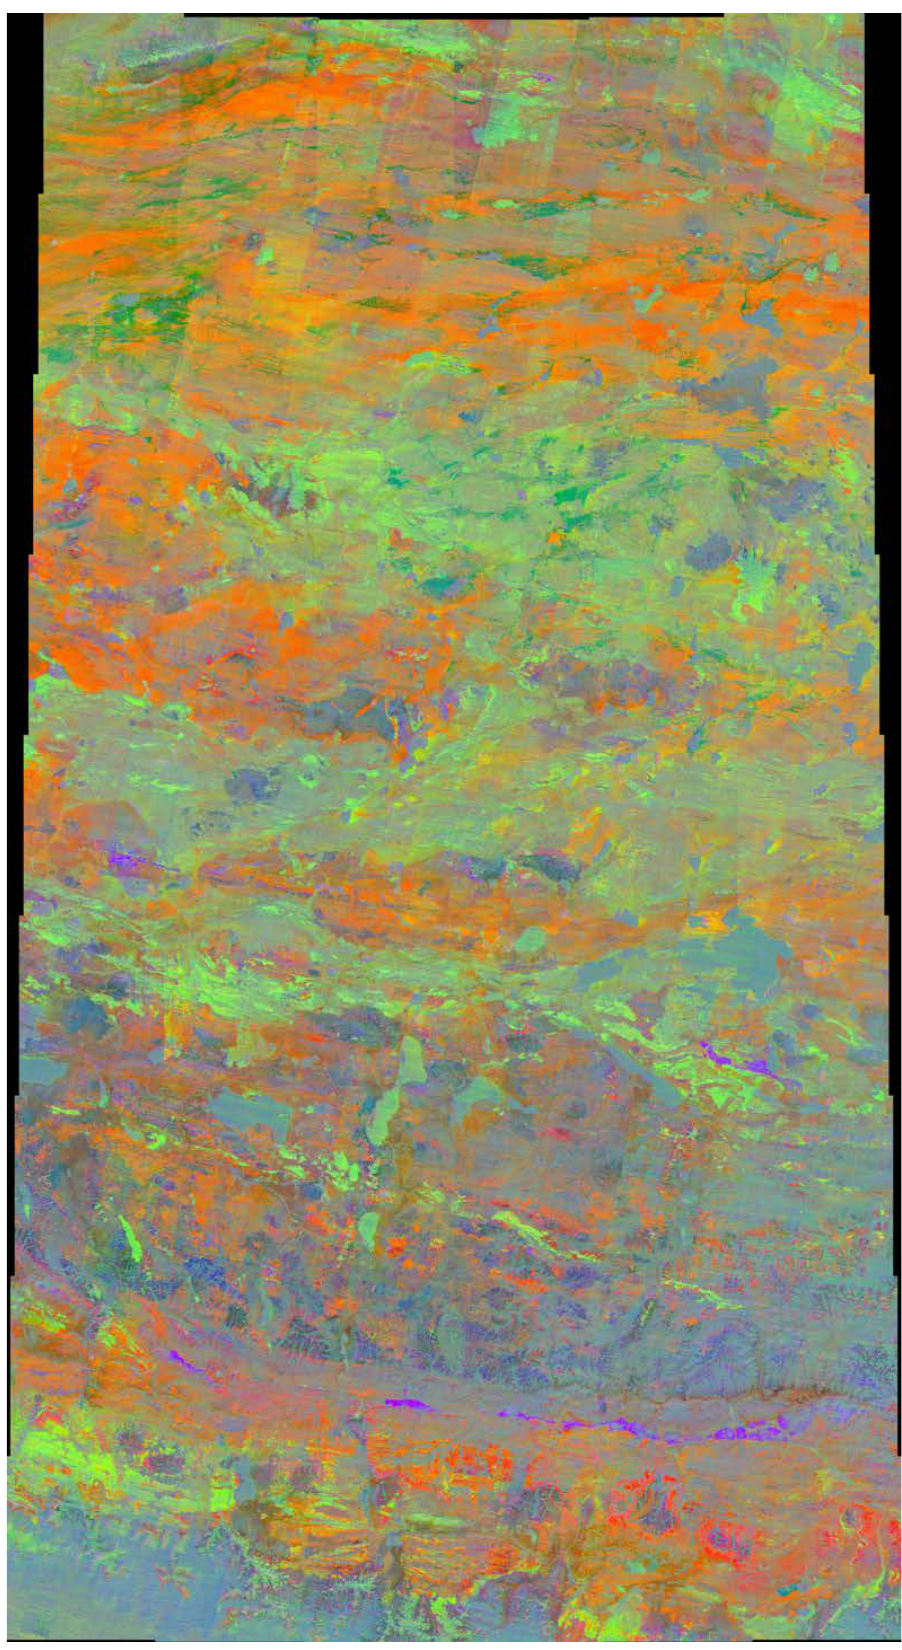
Figure A2. High resolution version of Figure 4 without annotated information.